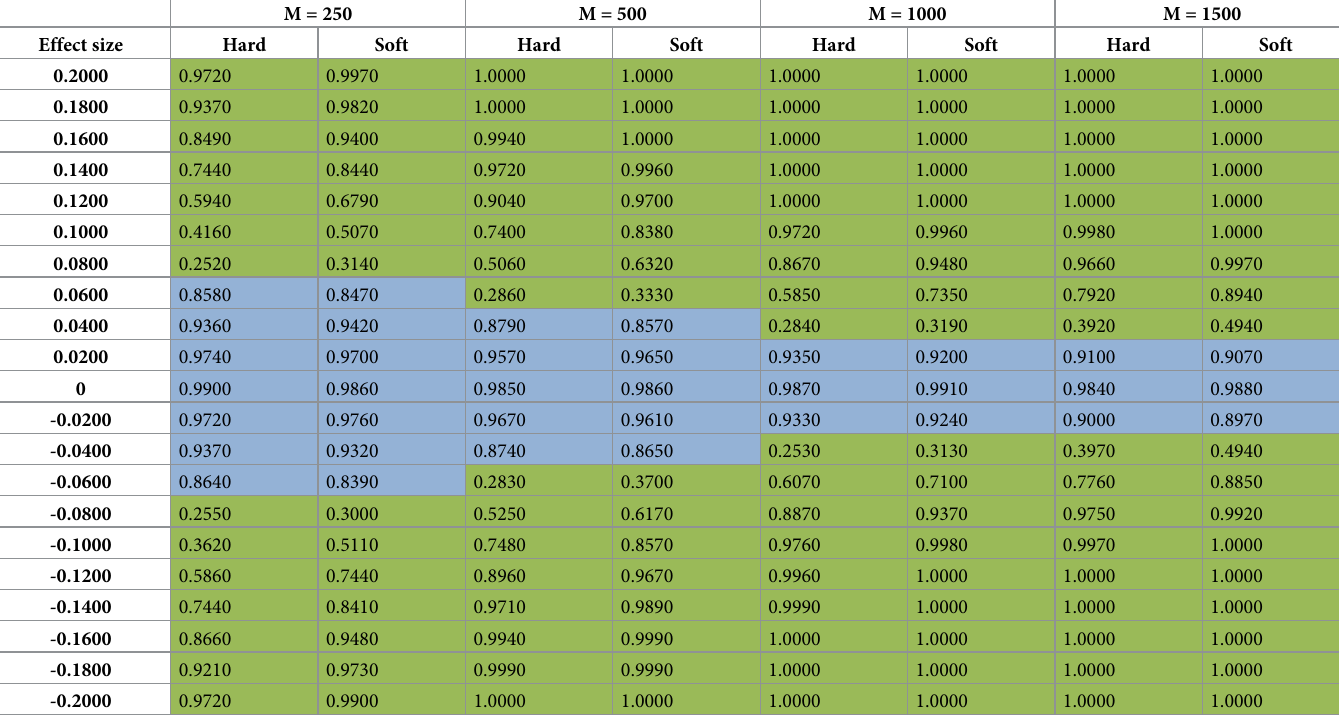
Table 4. The pr ( Correct association direction | H 1 is true ) in the green cells and pr ( Correct association direction | H 0 is true ) in the blue